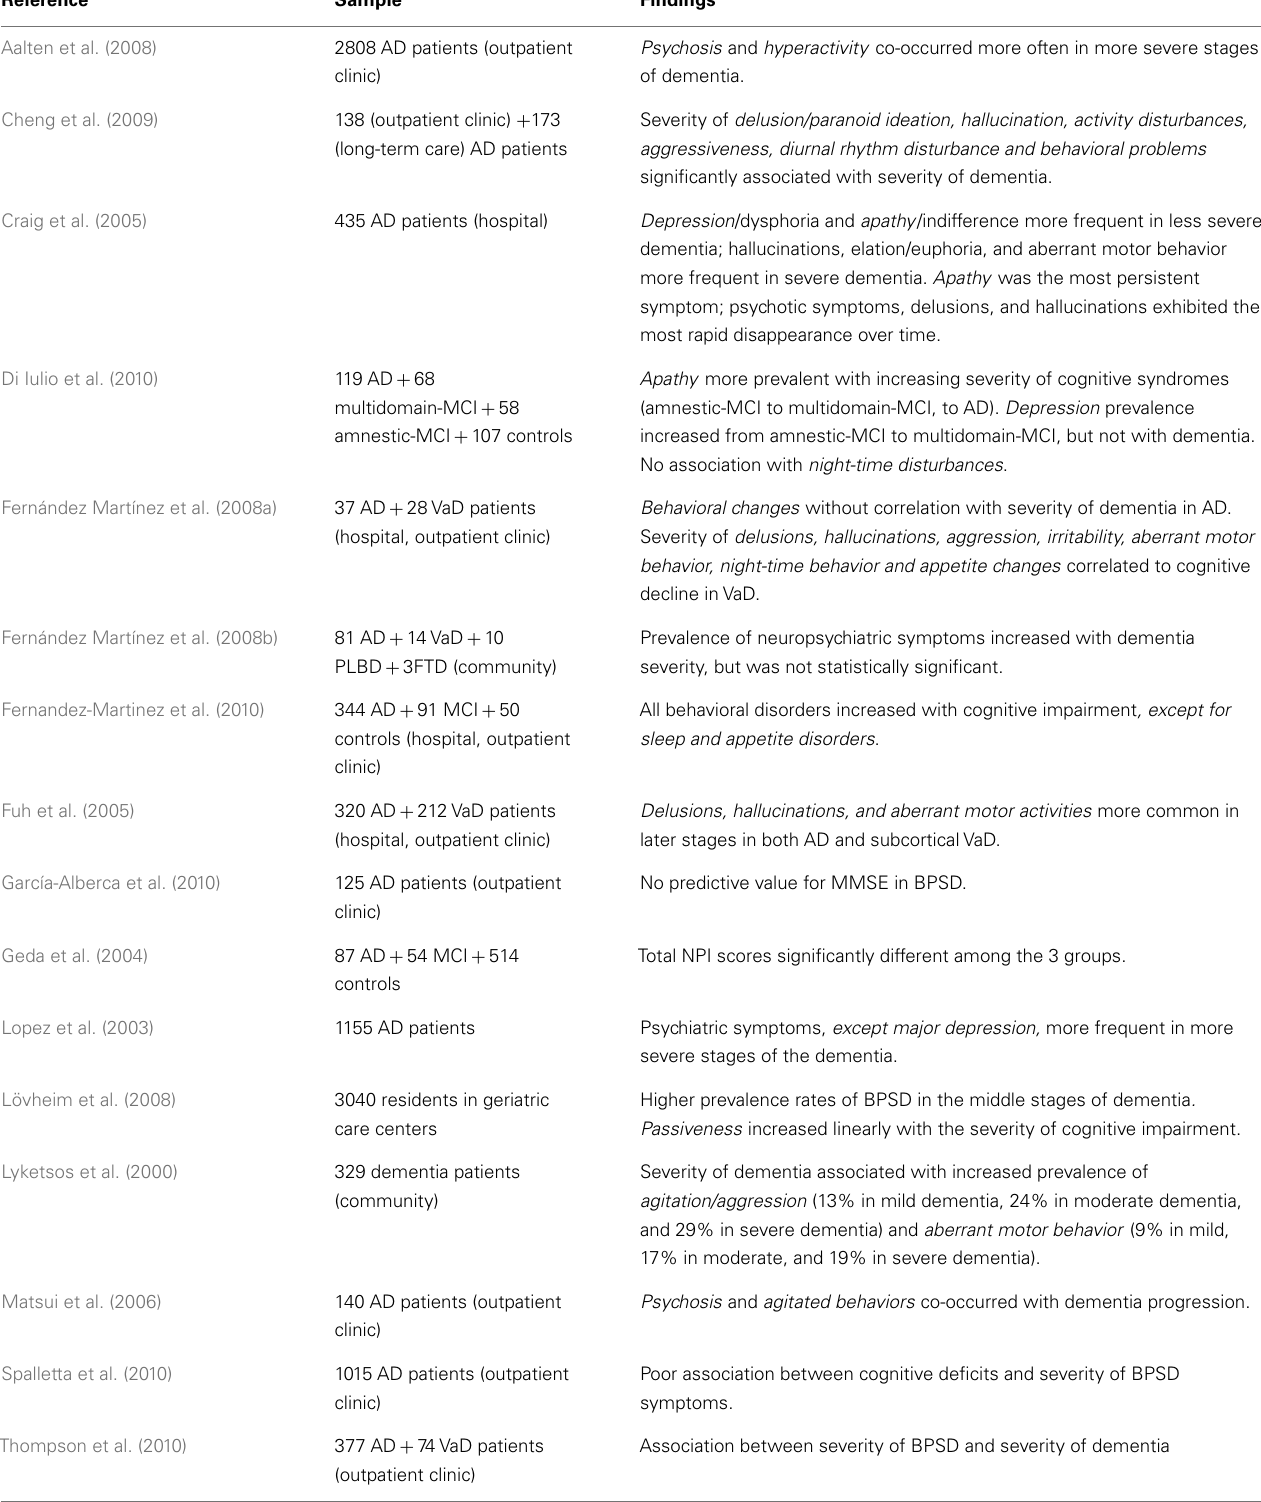
Table 2 | BPSD and dementia severity: cross-sectional